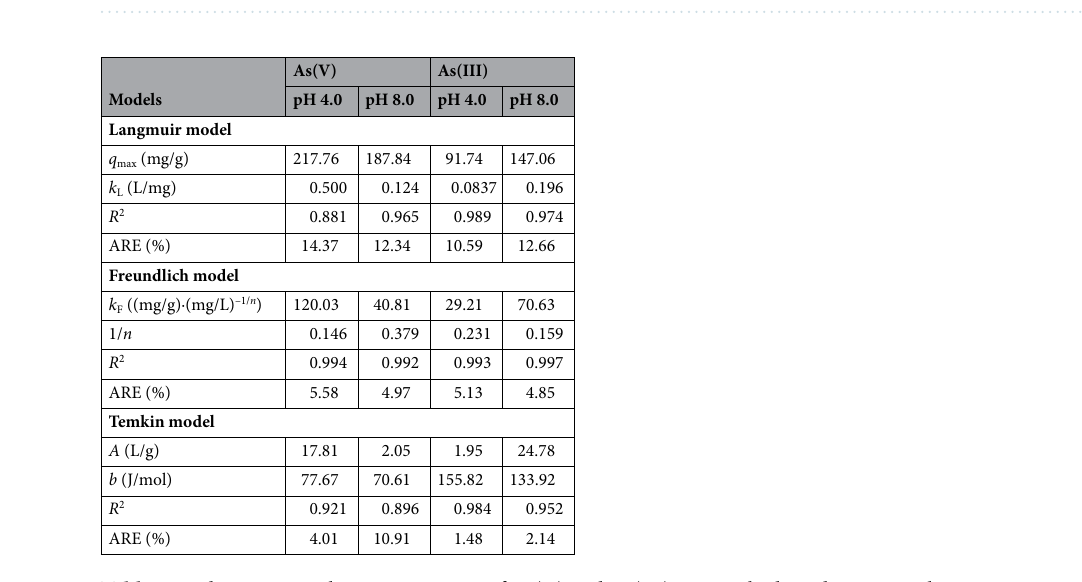
Table 3. Adsorption isotherm parameters of As(V) and As(III) on iron hydroxide nanopetalines at pH 4.0 and 8.0 with initial As concentrations ranging from 30 to 140 mg/L.